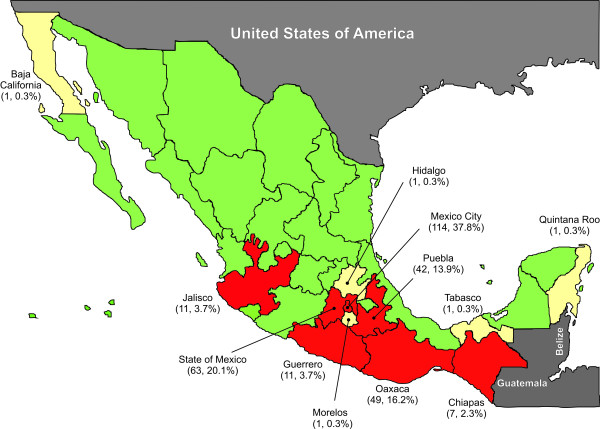
Geographical residence of the individuals included in the study. The map shows data for 302 antiretroviral treatment-naïve HIV-infected individuals. States in red account for 98.3% of the individuals included in the study. States in white account for 1.7% of the individuals of the cohort.